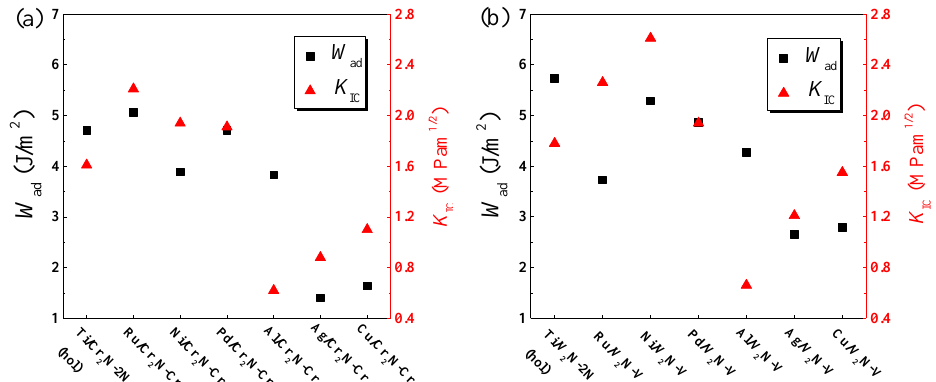
Figure 10. The combination of the interfacial work of adhesion W ad and the interfacial fracture toughness K IC of the ( a ) M/Cr 2 N and ( b ) M/V 2 N interface models considered, respectively.